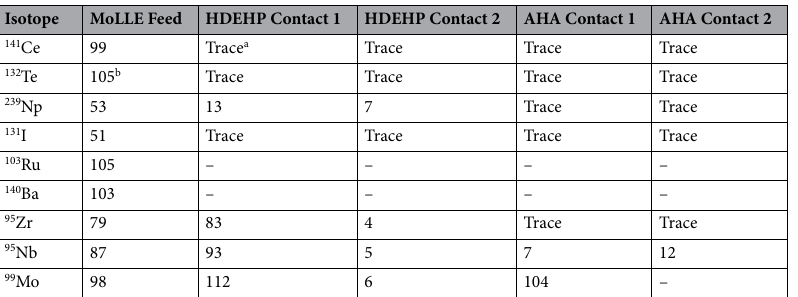
Table 1. Total activity percent for selected fission products and Np within MoLLE derived from the irradiated uranyl sulfate target (LEU). a < 1% or below quantification limits. b Values > 100% reflect γ-peak overlap or changes in attenuation and density across